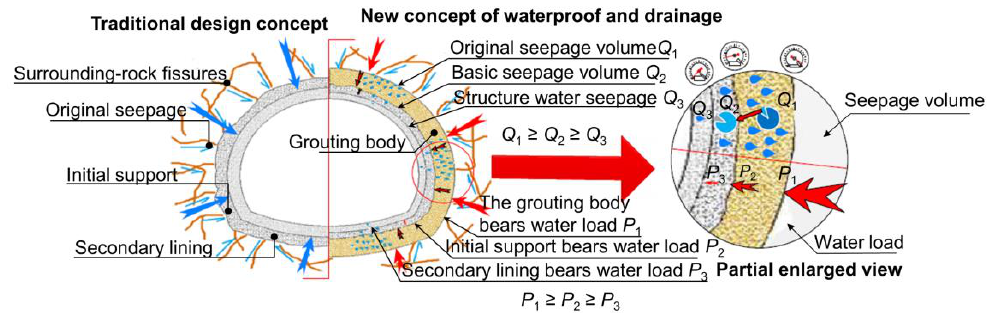
Figure 29. Comparison of waterproof drainage systems [183].